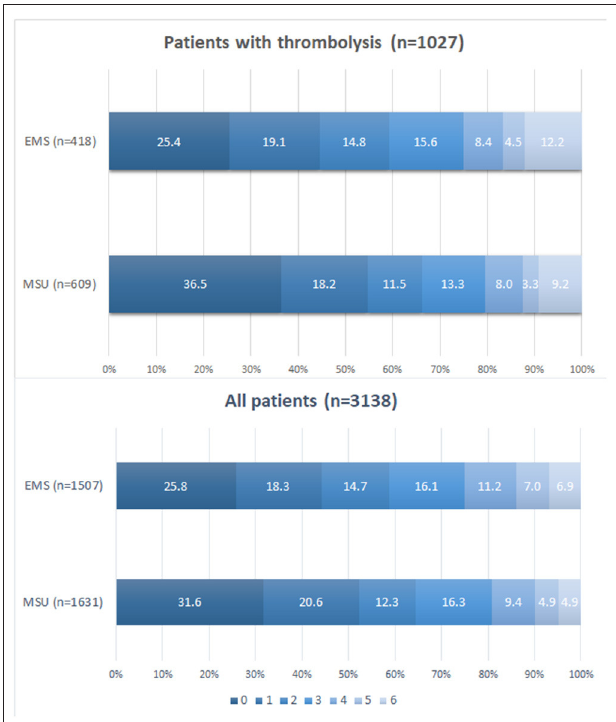
FIGURE 5 | Pooled analysis of scores on mRS at 90